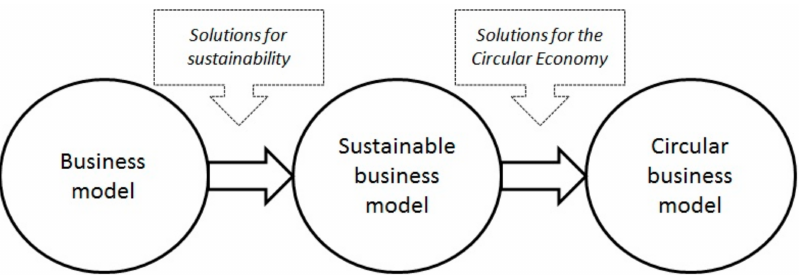
Figure 1. A holistic view of sustainable value integrating economic, environmental, and social value forms. Source: Own study based on